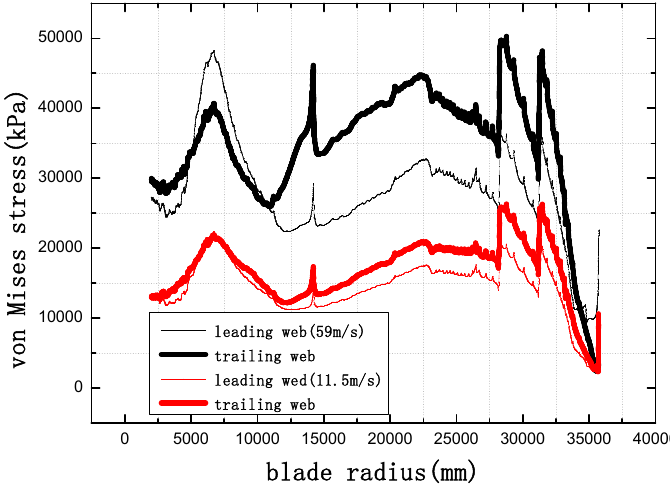
Figure 11. Maximum von Mises stress along webs.